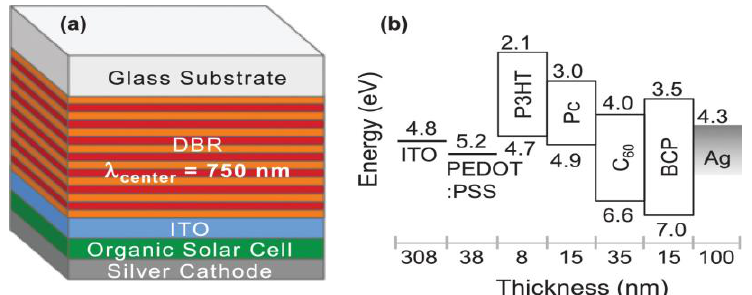
Figure 10. ( a ) Schematic diagram of distributed Bragg reflector light management system and organic solar cell and ( b ) device structure and energy levels of the pentacene solar cell with device thicknesses in nanometers. Reprinted with permission from Ref. [90]. Copyright 2013, AIP Publishing.